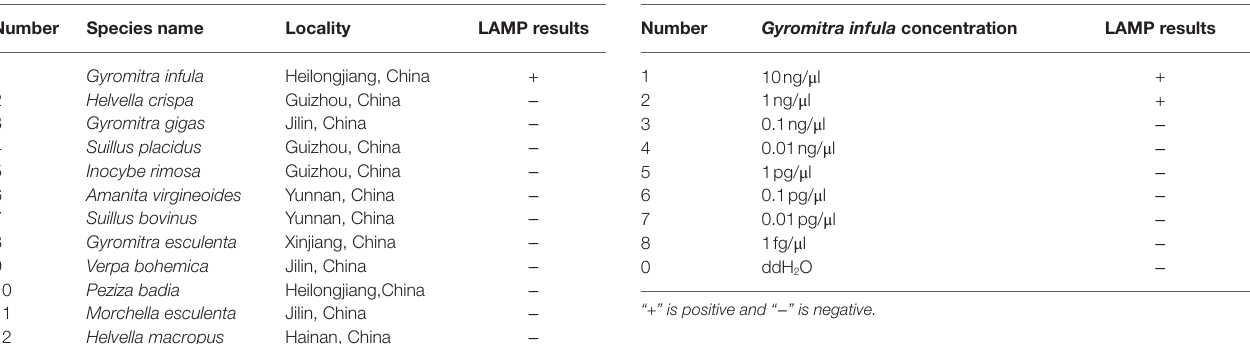
TABLE 3 | Specificity results of the LAMP primer set I of Gyromitra infula. TABLE 5 | Sensitivity results of the LAMP primers set of Gyromitra